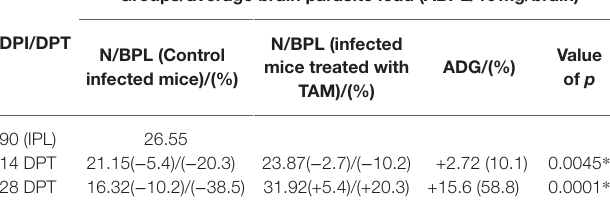
ABPL, Average brain parasite load; IPL, Initial parasite load; DPT, Days post-treatment; DPI, Day post-infection; ADG, Average difference between treated and untreated groups. * Means the statistical significance variance was considered significant when p <